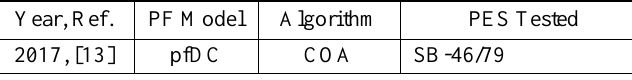
Table 3: Active power loss represented in the OF and